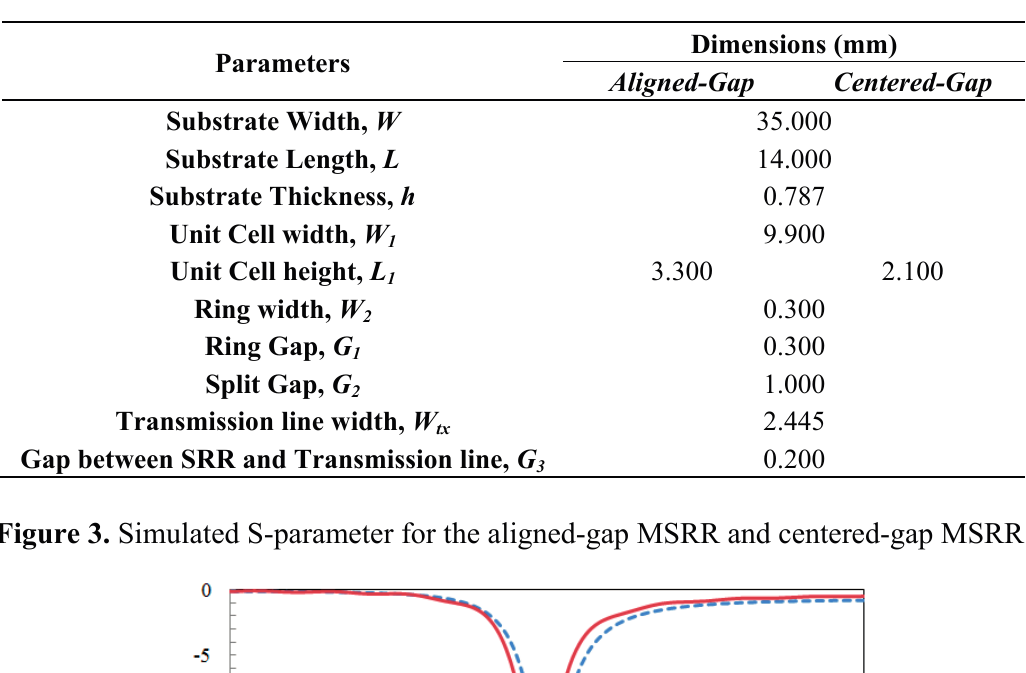
Table 1. SRR dimensions.